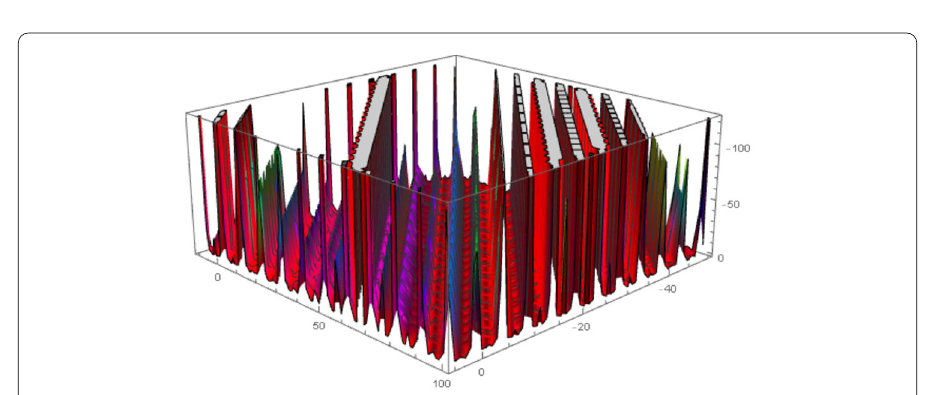
Figure 12 Periodic wave solution of u 15 ( η ) for α = 0.1, a 11 = 11, λ = 3, b 0 = 1, V = 12, b 1 =